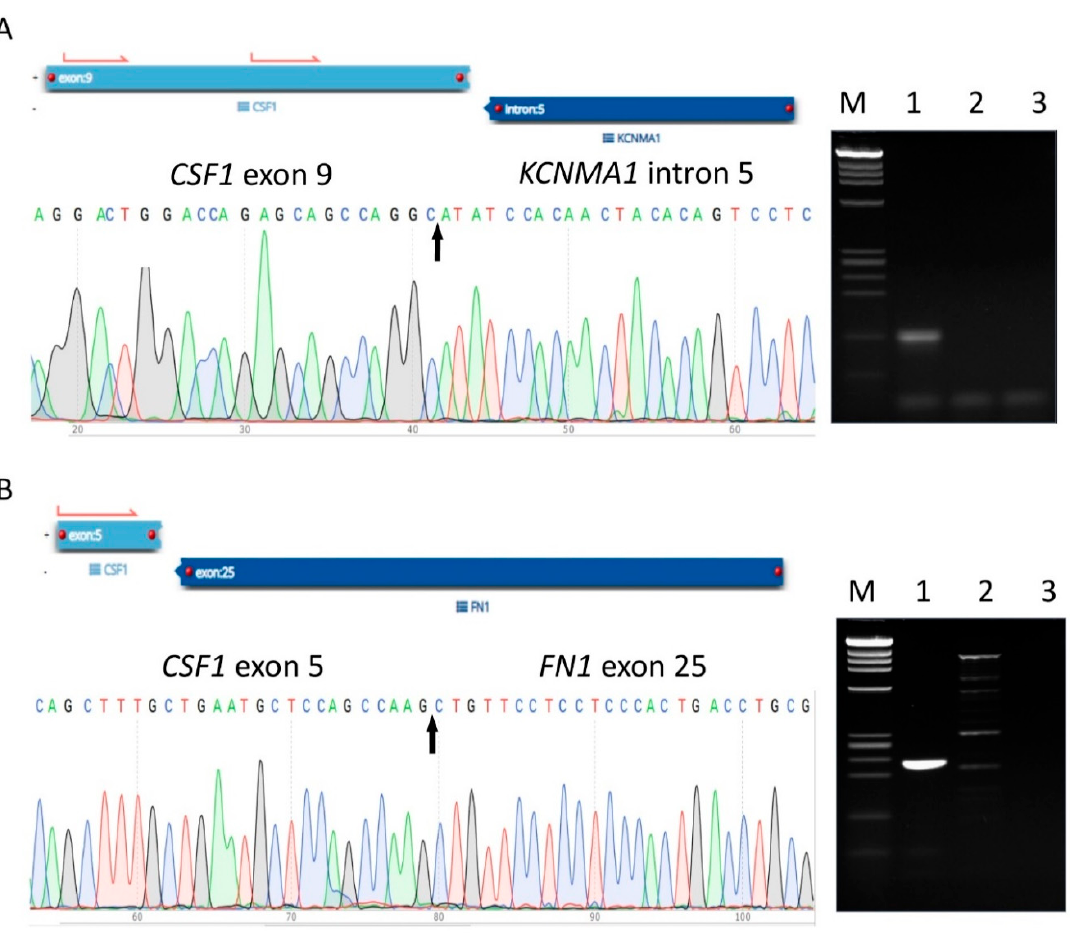
Figure 4. Detection and confirmation of CSF1 partner genes identified in conventional TGCTs. A partial sequence chromatogram is shown from each fusion transcript, with the arrow depicting the fusion breakpoint. Gel electrophoresis images display respective cDNA fragment amplification. A positive band can be seen in Lane 1, supporting the presence of the fusion product. M, DNA marker (Promega, Madison, WI, USA); Lane 1, patient case; Lane 2, HapMap normal RNA control; Lane 3, no template control (water control). Identification and validation of CSF1-KCNMA1 ( A ) and CSF1-FN1 ( B ) fusion transcripts by AMP, Sanger sequencing, and RT-PCR.